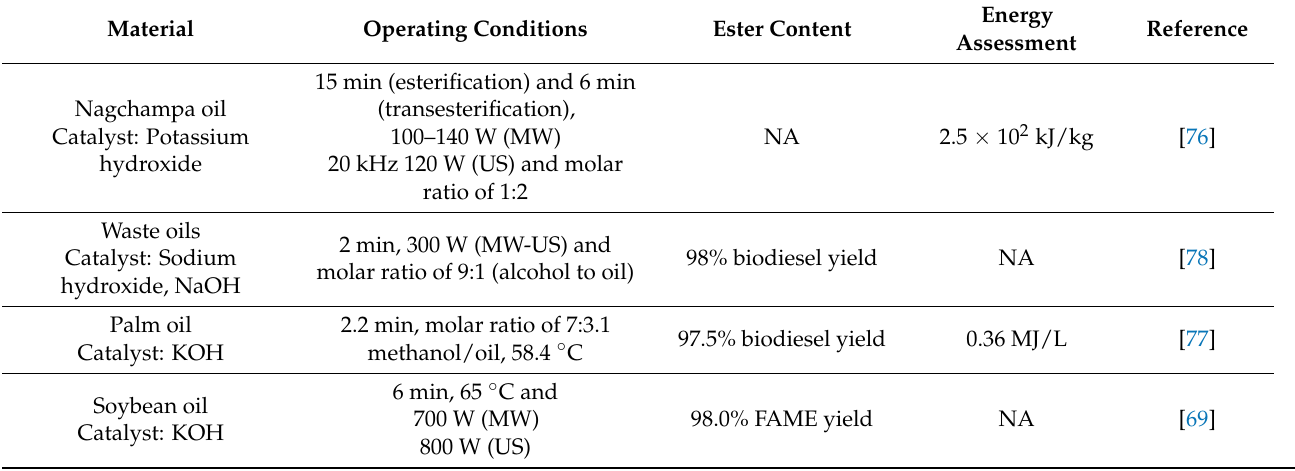
Energy Assessment